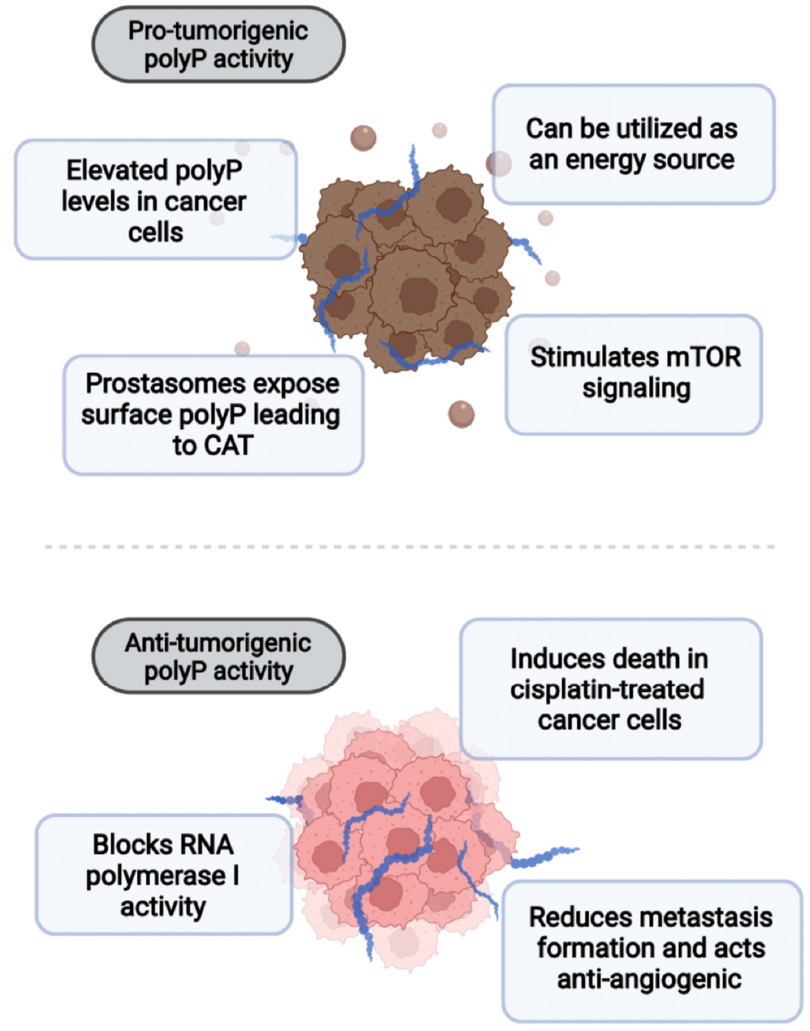
Figure 4. PolyP plays a dual role in cancer. On the one hand, it can act pro ‐ tumorigenically by stimulating mTOR signaling or being utilized as a direct source of energy. Moreover, prostasomes of prostate cancer expose polyP on the surface, leading to cancer ‐ associated thrombosis (CAT). On the other hand, polyP has been shown to block RNA polymerase I activity, reduce metastatic spread, and inhibit angiogenesis. PolyP also induces death in cisplatin ‐ treated cancer cells.